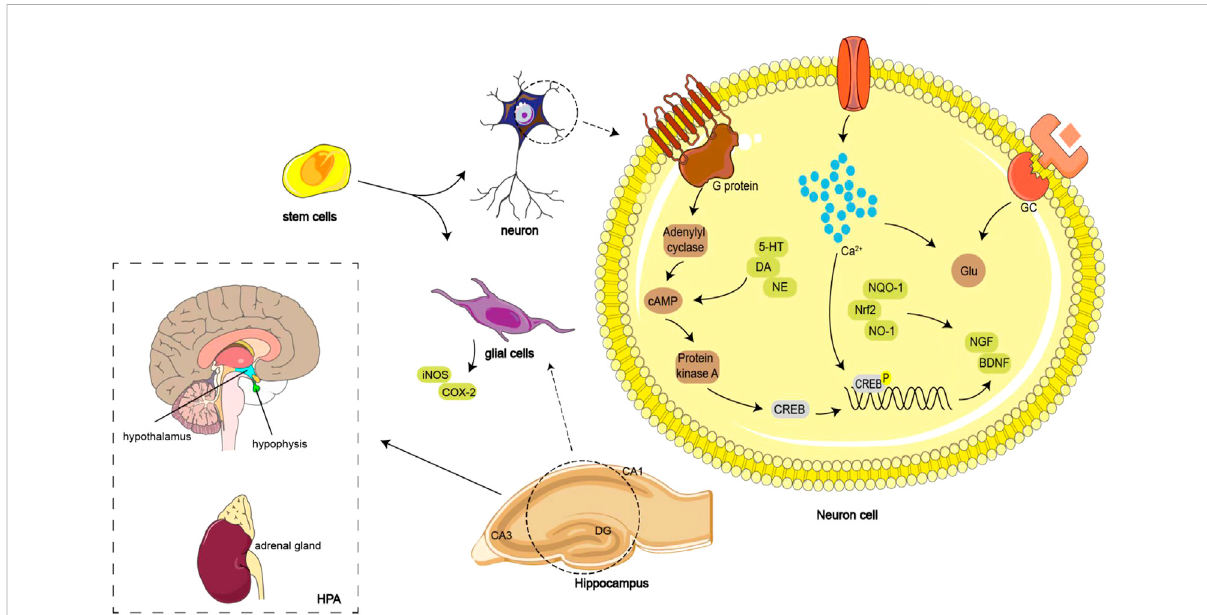
FIGURE 1 Mechanismsofantidepressanteffectof Valeriana :promotingthelevelof5-HT,theproliferationofhippocampalneurons,andtheexpressionof phosphorylatedcAMPresponsiveelement-bindingprotein.Inhibitingserumcorticosteroneandglutamatelevels,reducingglucocorticoidelevation, and stabilizes the